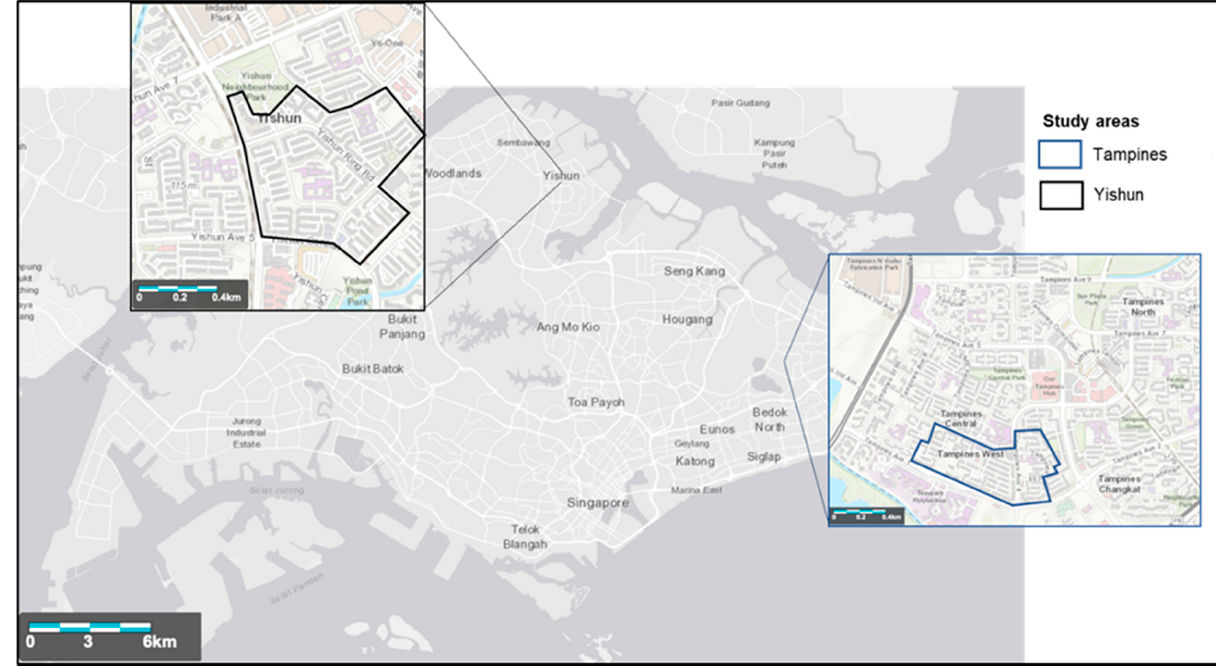
Figure 1. Locality of Project Wolbachia– Singapore’s study sites. The base layer was obtained from https://landsatlook.usgs.gov/ (accessed on 22 August